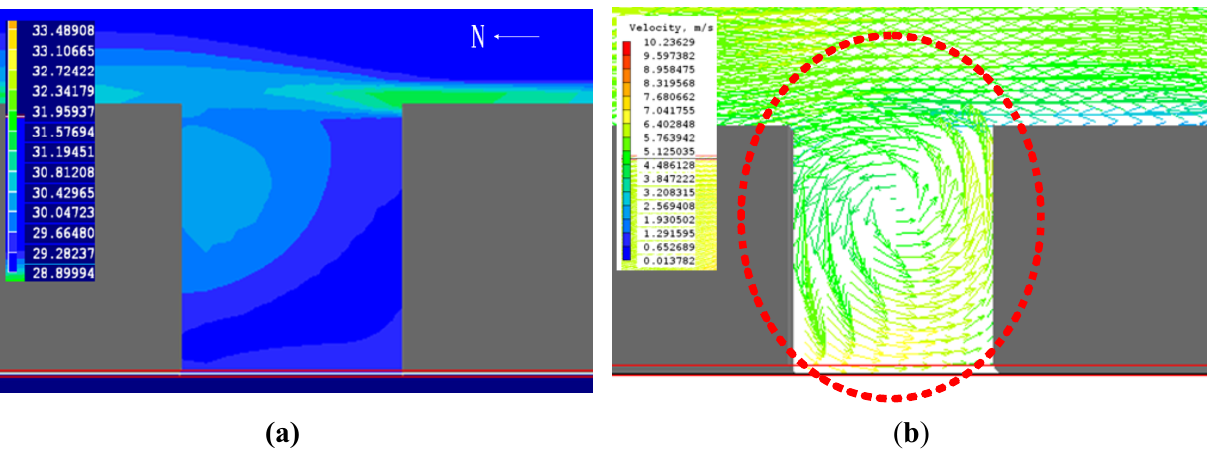
Figure 6. Air temperature and flow pattern on an asphalt road (G9 layout; X = 250